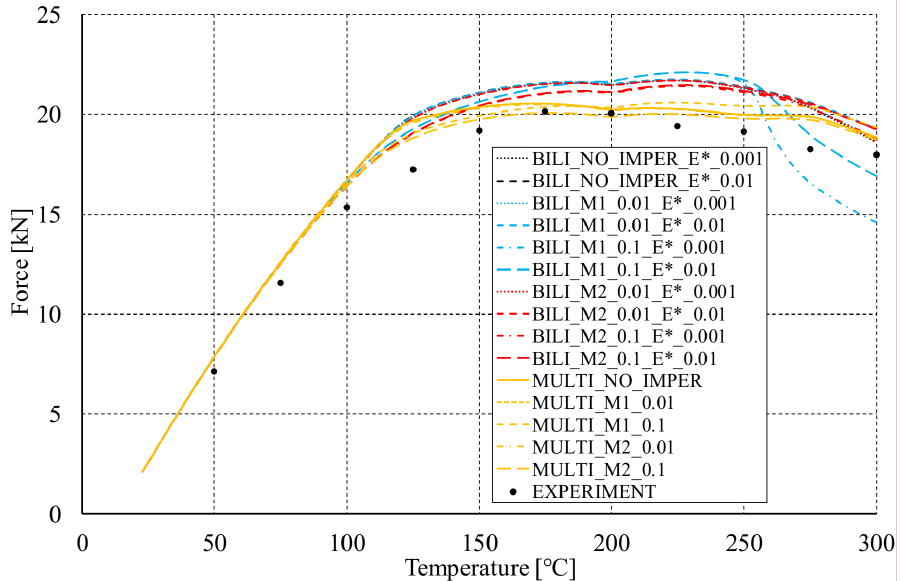
Figure 10. Reaction forces at the end of the heating process.